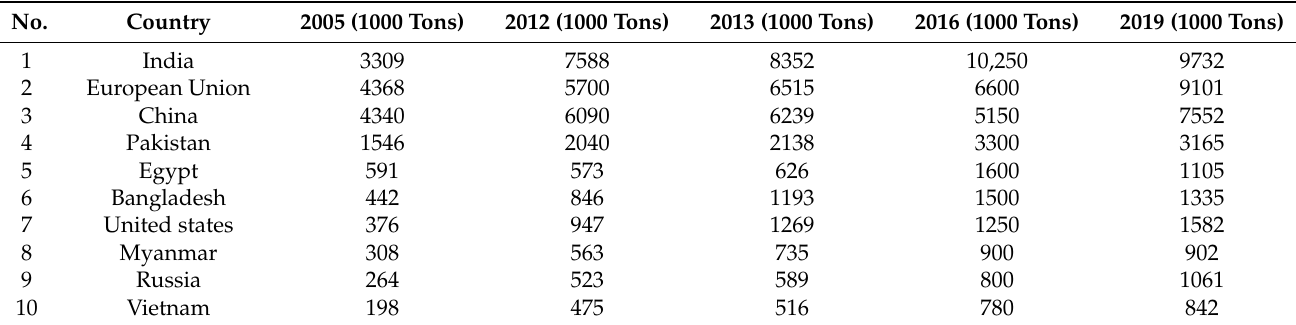
Table 2. Worldwide major consumers (Source: Our World in